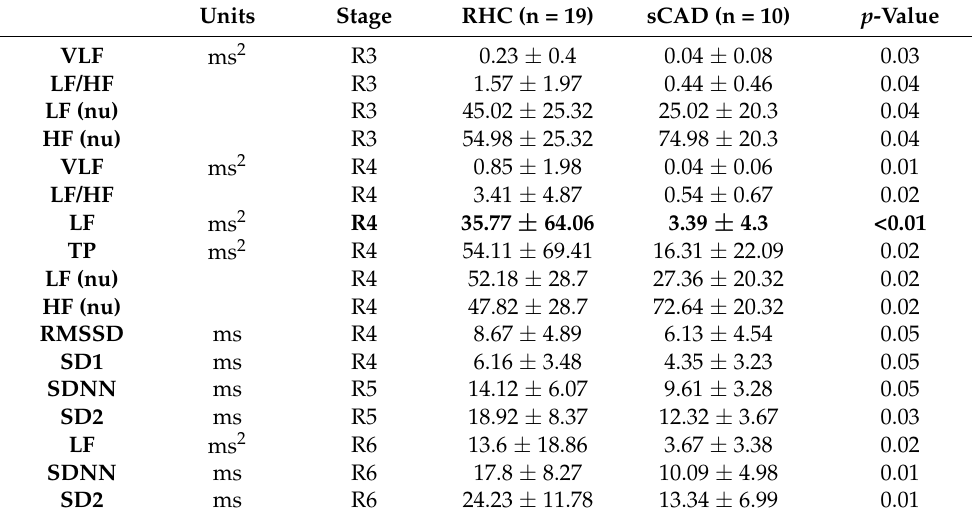
Table 1. A comparison of HRV indices in different recovery stages between the RHC and the sCAD groups. Only particular recovery stages are listed in which the HRV indices between the two groups are significantly different. The LF in R4 in bold exhibited the best performance ( p < 0.01).